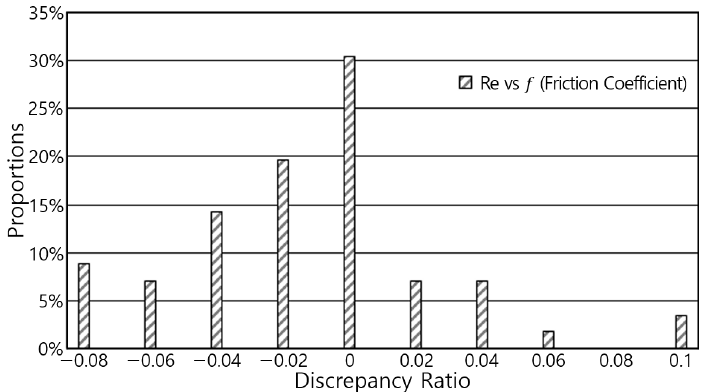
Figure 9. The discrepancy ratio for f and Re calculated using Yuen’s data.